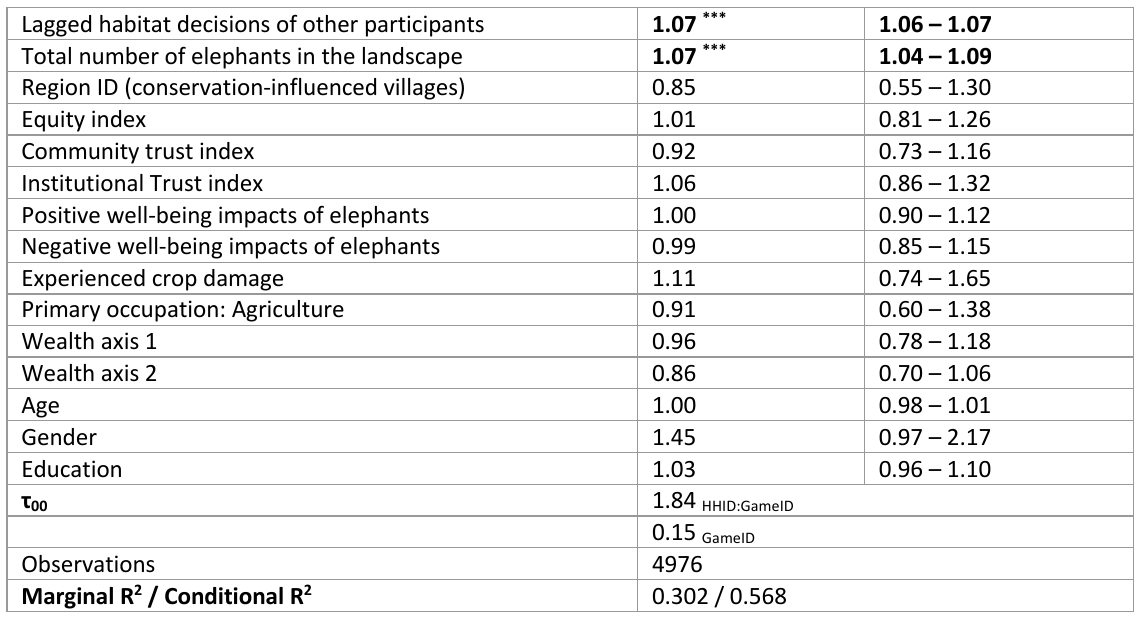
Table A1.6: Effects of subsidy levels and other game conditions on kill and habitat decisions (only the monetary treatments were included in the model). For categorical variables the level that is represented by the intercept term is shown in parentheses.